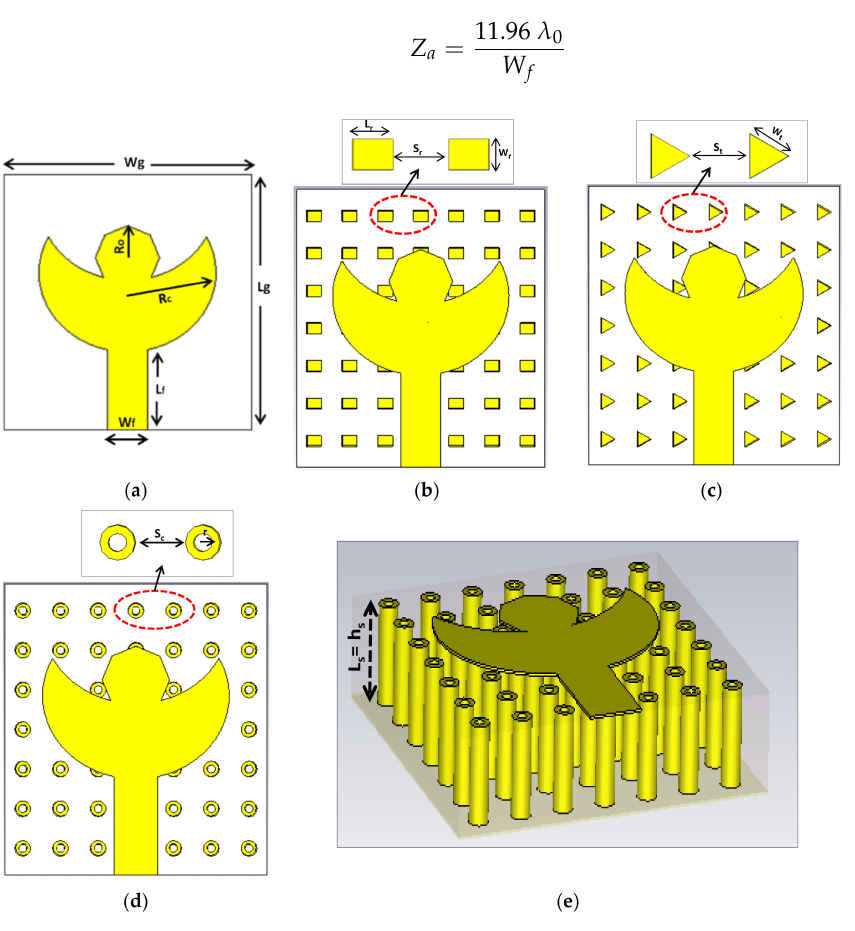
Figure 1. Different variants of the Proposed THz antenna ( a ) Type-A antenna ( b ) Type-B antenna